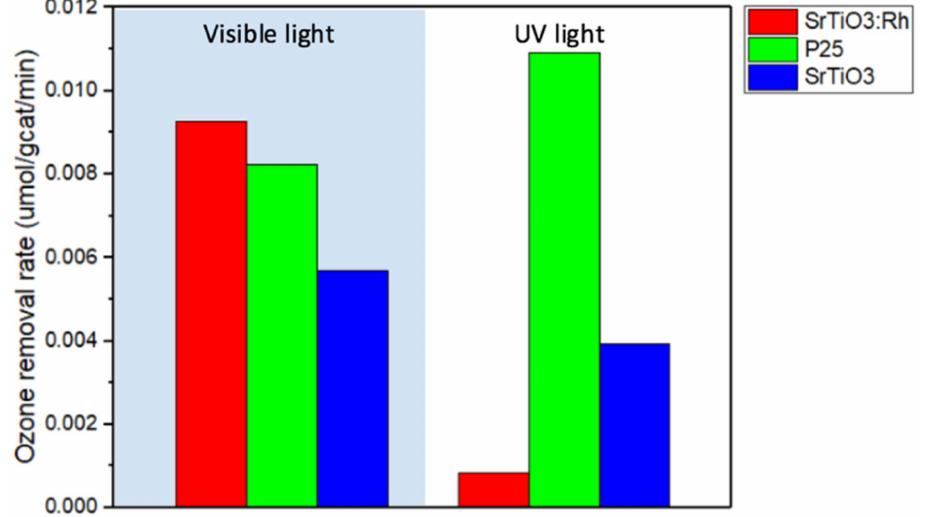
Figure 2. The averaged ozone removal rate in the batch